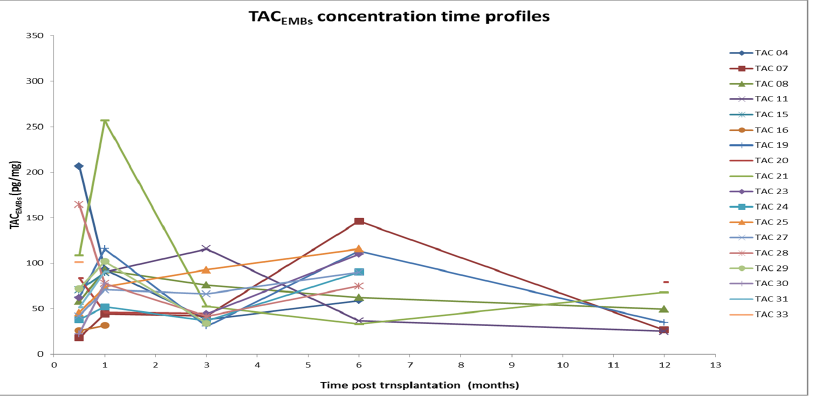
Figure 1. Concentration–time profiles of TAC in EMBs (18 patients). TAC: Tacrolimus; EMB: Endomyocardial biopsy.